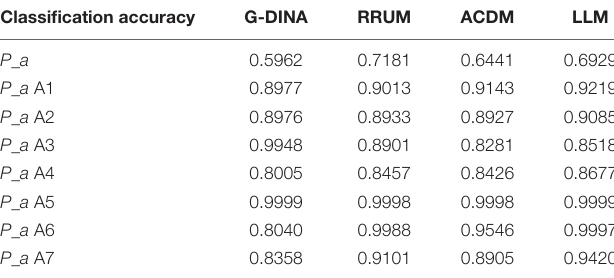
TABLE 7 | Classification accuracy Pa . Classification accuracy